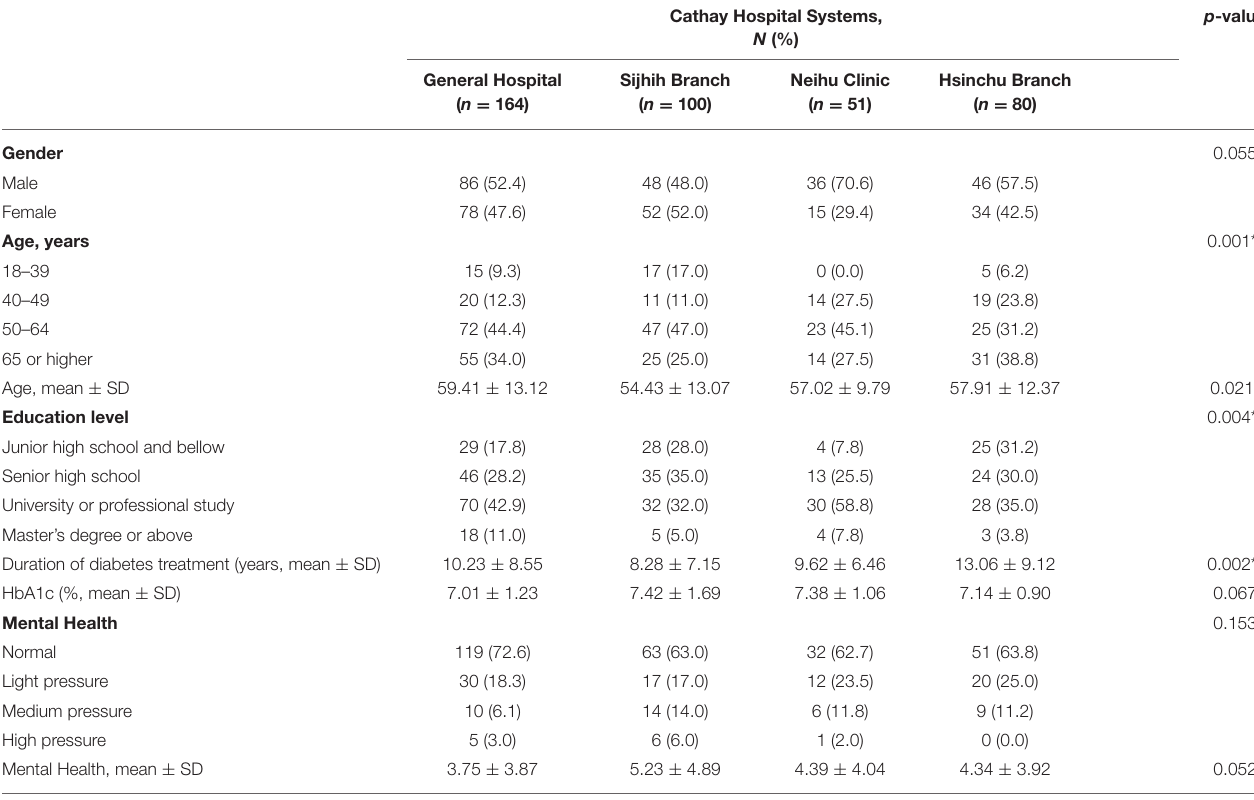
TABLE 2 | Demographic characteristics of samples.